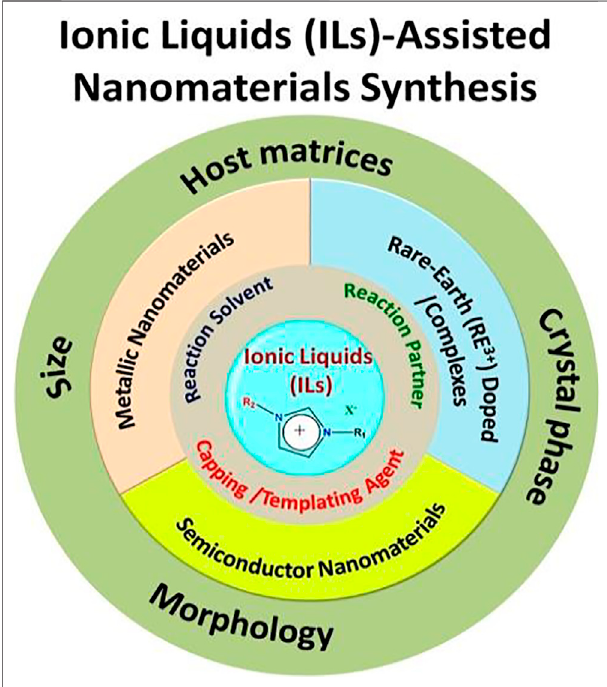
FIGURE 5 | The role of ionic liquids in the synthesis of various classes of nanomaterials.